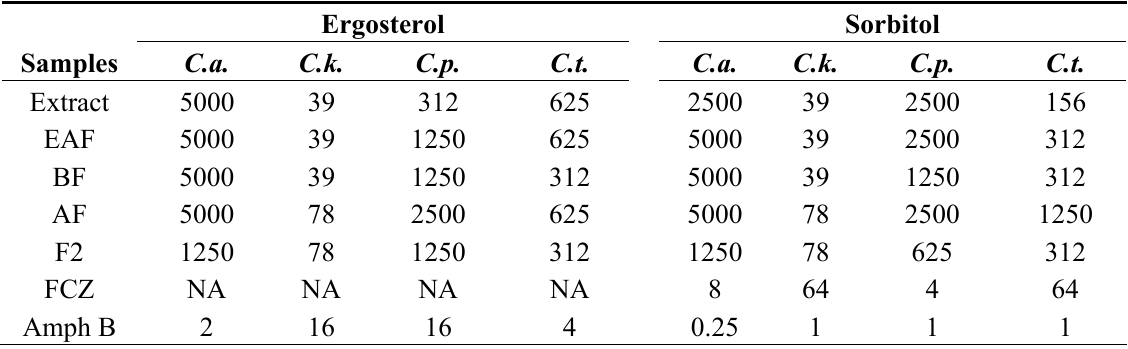
Table 3. Antifungal activity of the plant preparations in the presence of ergosterol or sorbitol, in µg/mL. Samples